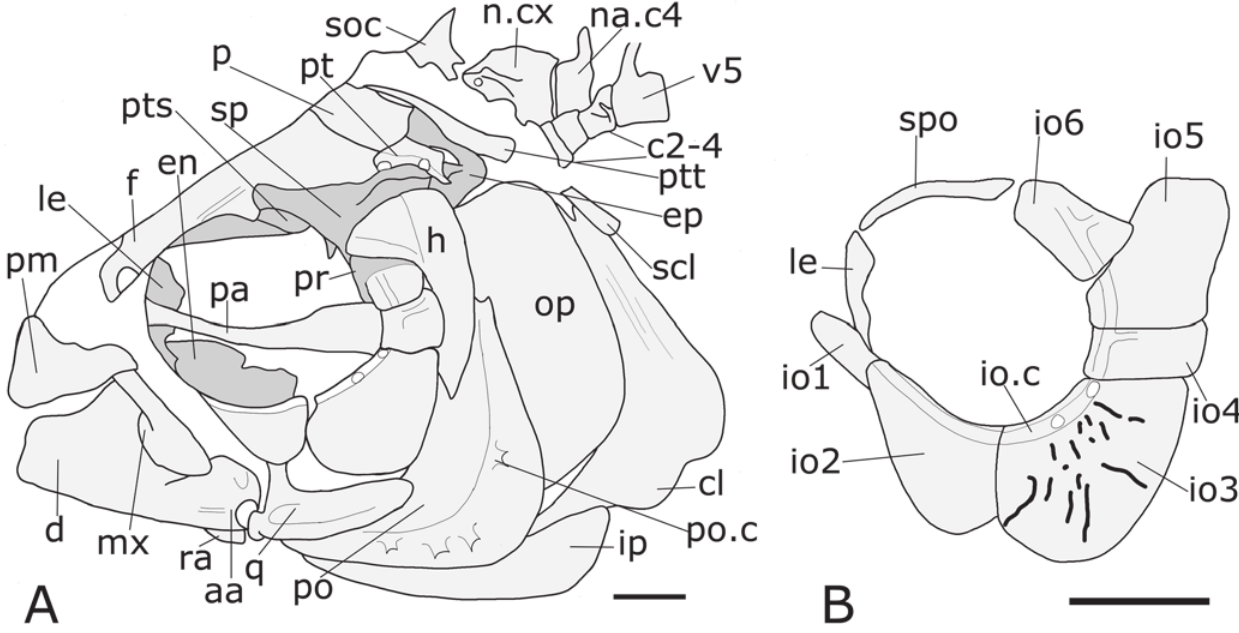
Fig. 3. Interpretative drawings for † Bryconetes enigmaticus n. gen. n. sp. based on the holotype (UFRGS 19114) and a silicone cast of the counterpart. A, anterior region of the fish; B, circumorbital bones, showing the striae and punctuation from